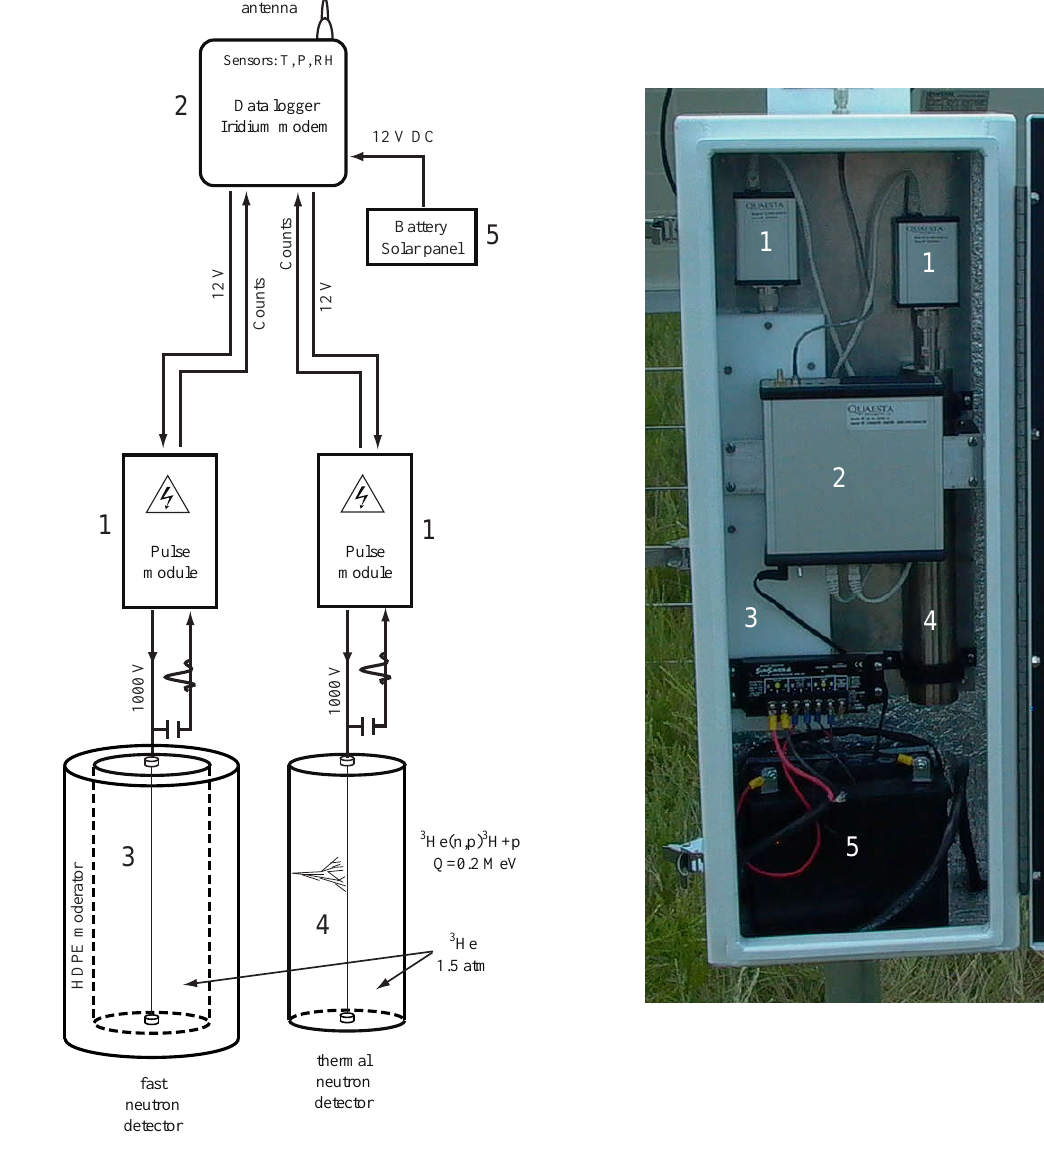
Fig. 9. A cosmic-ray probe consists of neutron detectors connected to electronic pulse modules, data logger, satellite modem, and solar panel and rechargeable battery. Please also see the manufacturer’s web page for additional information about the cosmic-ray probe: http: //hydroinnova.com/ps